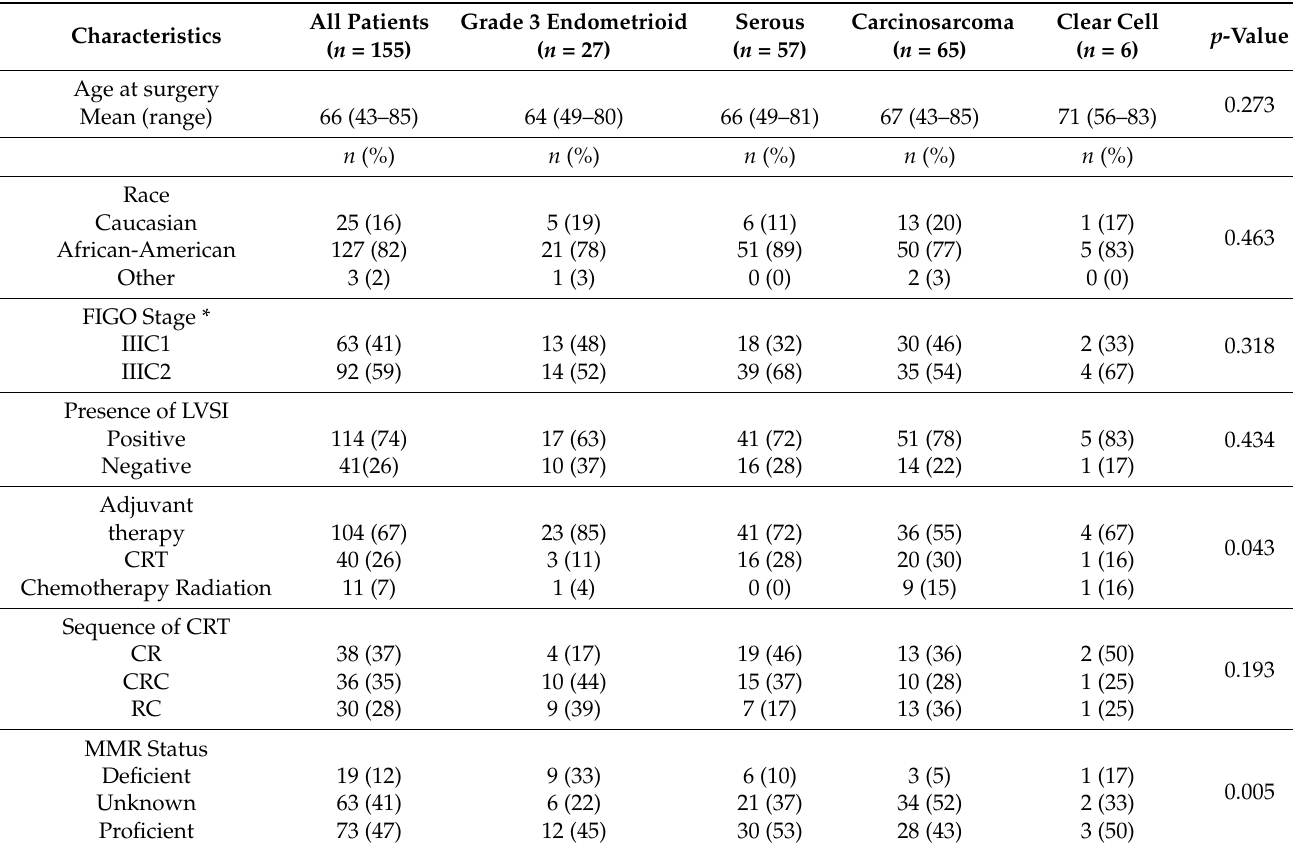
Table 1. Clinical and pathologic